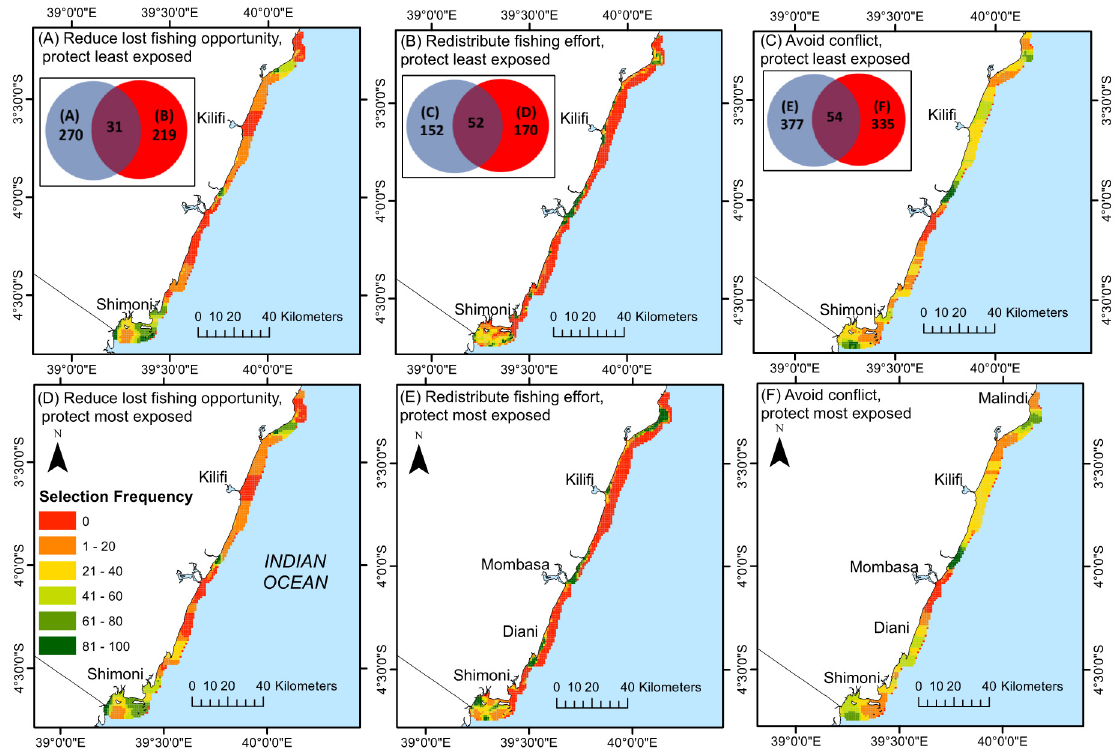
Figure 5. Area selection frequency (of 100 Marxan runs) based on prioritization analysis when ( left ) reducing the cost of lost fishing opportunity ( middle ) redistributing fishing effort to minimize impacts and ( right ) avoiding potential conflicts between ocean based activities (e.g., tourism, fishing, sand mining, oil exploration) and conservation. Figures in the first row ( A , B , C ) are based on protecting areas least exposed to climate change, while the second row figures ( D , E , F ) are based on protecting most exposed areas. Inset plots show the total area of the planning units (km 2 ) with selection frequency >80% for each planning objective as labeled, with overlapping sections representing the area where selection frequency was >80% in both scenarios aiming to minimize environmental exposure and in scenarios aiming to maximize environmental exposure.